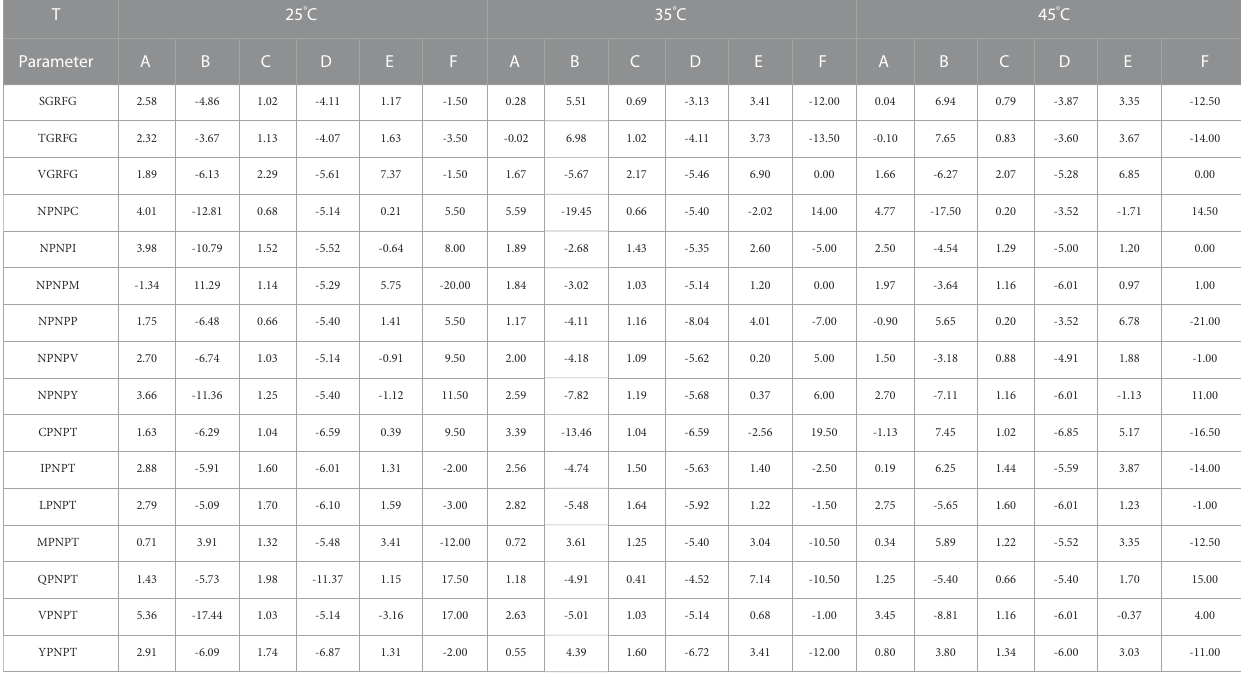
TABLE 6 ( Continued ) Parameter results of fi tting with φ and pH at different